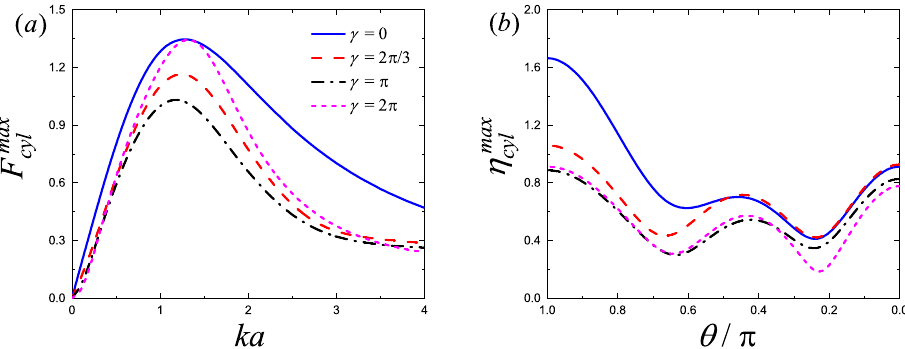
Figure 10. Variation in non-dimensional wave force and run-up on the interior cylinder for different values of γ with β = π /3, h / a = 1, k x / k = 0.5, U 0 = 0.4 m/s, G = 1, and α = π − γ /2: ( a ) force; ( b ) run-up, ka =